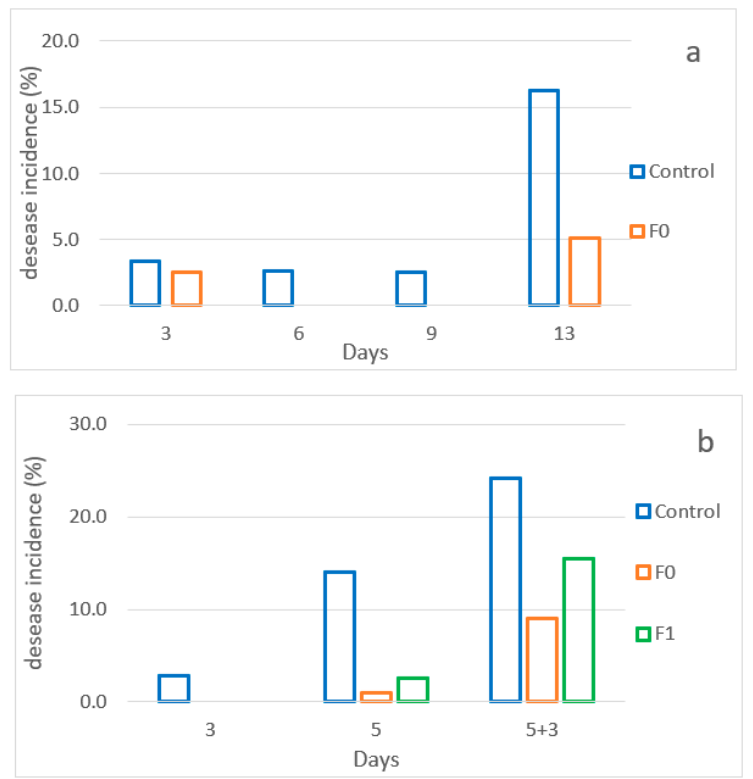
Figure 6. Decay incidence (%) per treatment/each analysis date. Control: Clamshell containing raspberries without the active pad (CP). F 0 : Clamshell containing raspberries with active pad F 0 . F 1 : Clamshell containing raspberries with active pad F 1 . ( a ) shows the desease incidence for the first set of analysis after 3, 6, 9, 13 days. ( b ) shows the desease incidence for the second set of analysis after 3, 5 and 5 + 3 (after 3 days at room temperature) days.